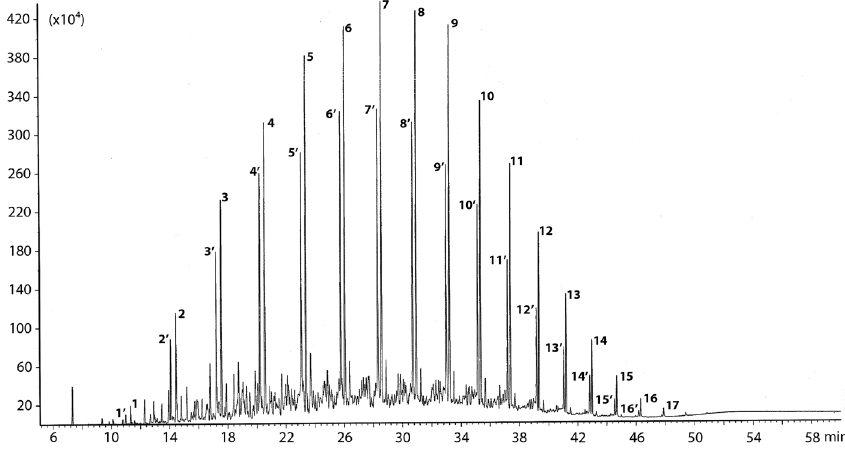
Fig. 5. A GC-MS chromatogram of the aliphatic component of the neutral